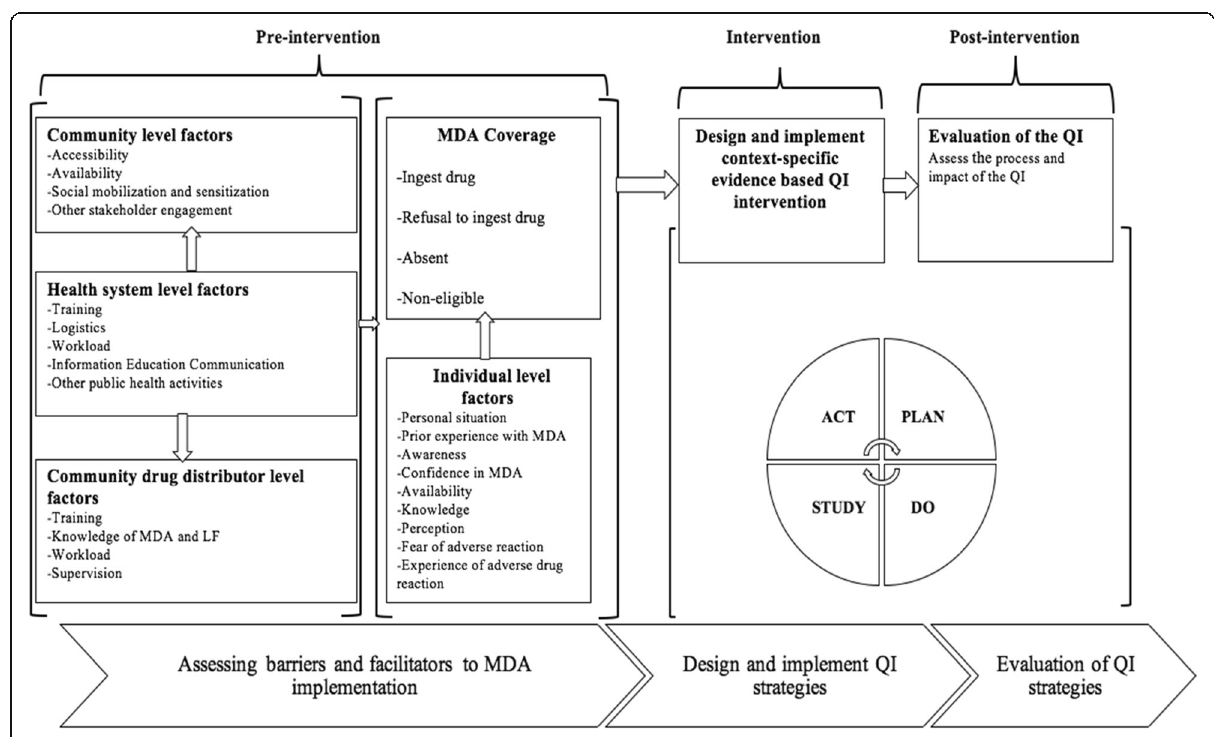
Fig. 1 Conceptual framework showing the connection between the study